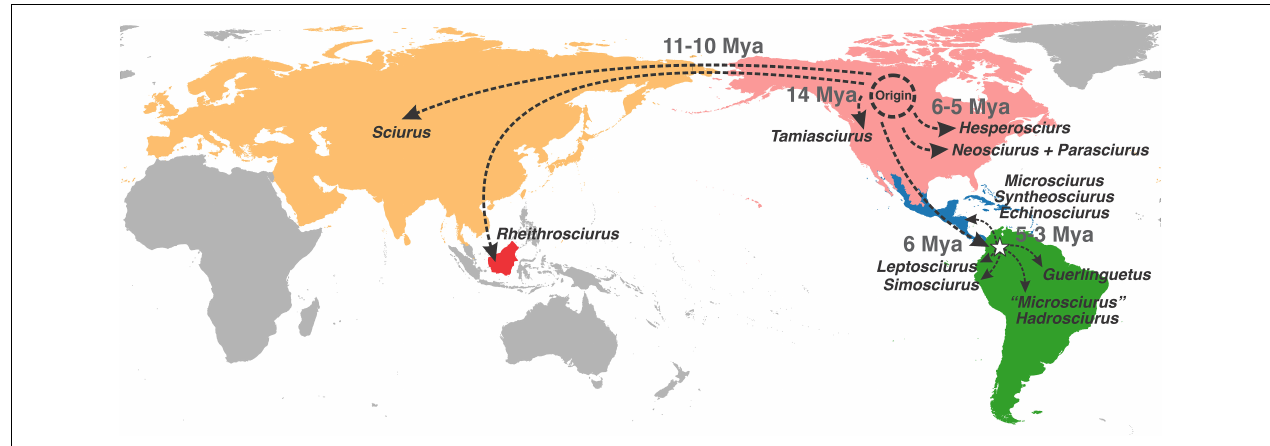
FIGURE 4 | Map summarizing the inferred colonization scenario for the tribe Sciurini showing the timing and the place of its origin and diversification in North America, the two independent dispersions into Eurasia, the invasion of South America, the re-invasion of Central America, and the diversification in South